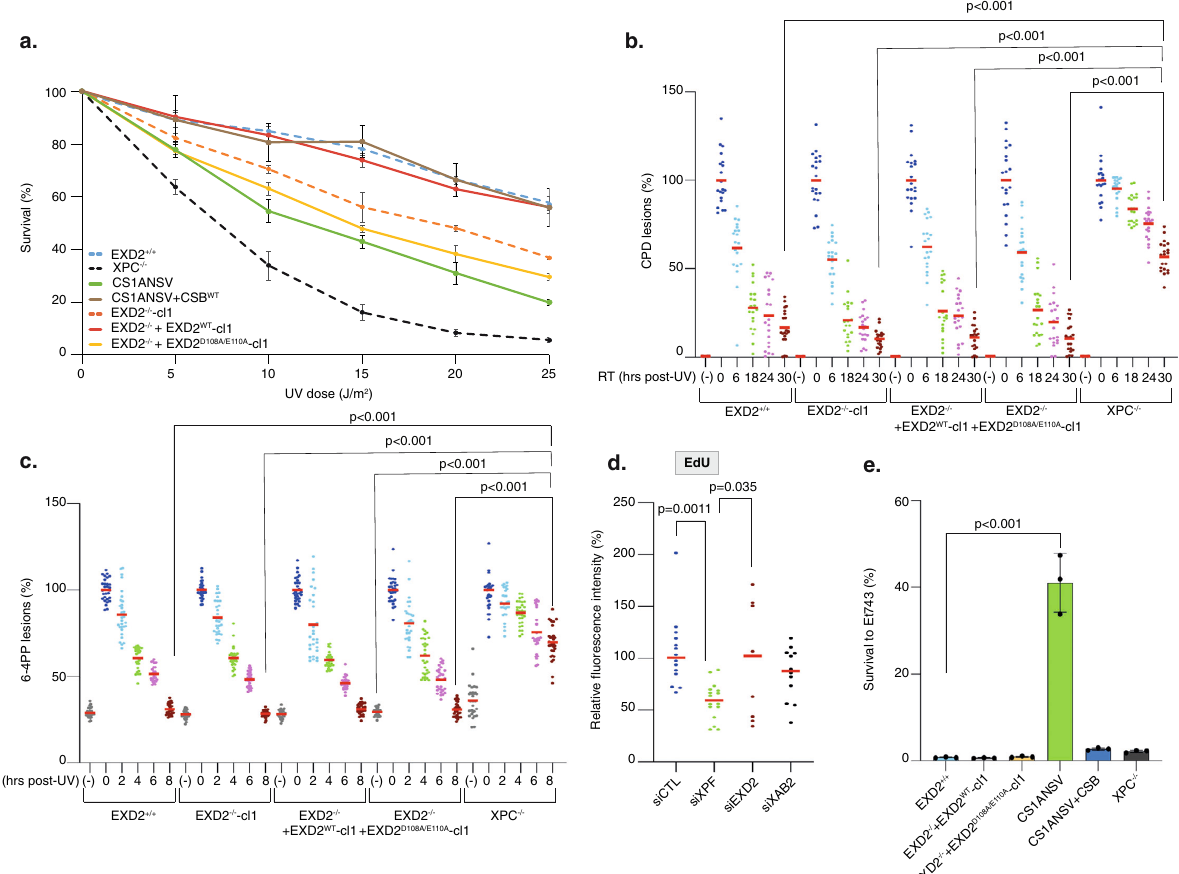
Fig. 3 | Knockdown ofEXD2 nuclease activitysensitizes cells toUV irradiation. a Cells were treated with increasing doses of UV irradiation and survival was determined 48h later. Data were normalized to the mock treatment controls (as value of 100). The values are the means of three independent experiments (+/ − SEM) (Technical triplicates). Source data are provided as a Source Data fi le. b , c RemovalofUVlesionswasmeasuredincells,harvestedatdifferenttimepoints post-UV(15J/m 2 )asindicated.Cellswerelabeledwithanti-CPD( b )oranti-6-4PP( c ) antibodiesandsignalswerequanti fi edusingImageJatthedifferenttimesindicated inthe fi gure.Graphrepresentsthe%oflesionsremaininginthegenomeatdifferent time points normalized to the amounts of lesions measured immediately after UV irradiation (as a value of 100%). For each time point, a mean of 30 cells has been analyzed. Red bars indicate mean integrated density. RT; recovery time. (-); cells were mock-irradiated. 0; cells were irradiated and fi xed immediately. One-way ANOVA with post-hoc Tukey adjustment comparisons were used to determine the